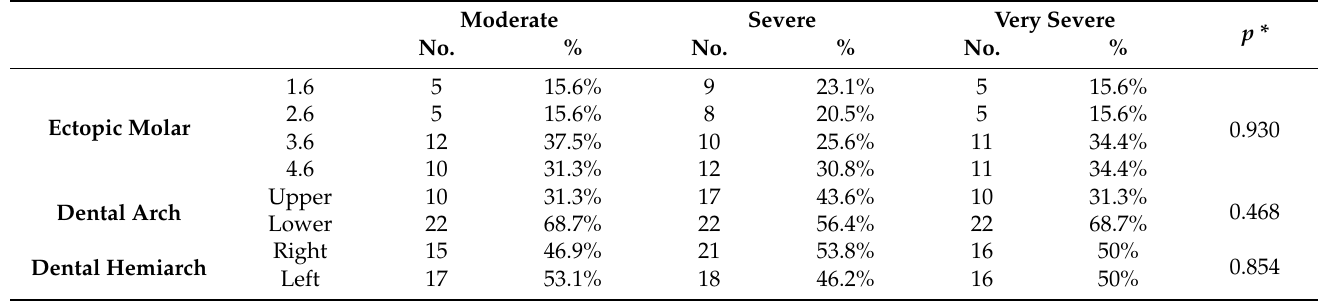
Table 4. Distribution of the ectopic molars according to severity and type of molar/affected dental arch/affected dental hemiarch. Moderate Severe Very Severe